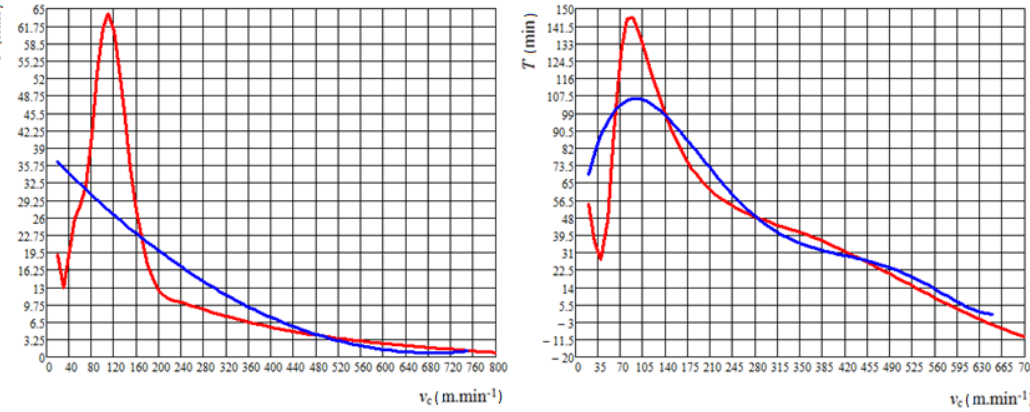
Figure 15. Regression analysis of T-v c dependence for Al 2 O 3 ( left ) and Al 2 O 3 + TiN ( right )—CNC machine (red curve—values obtained from experiment; blue curve—values determined in accordance with ISO 3685).